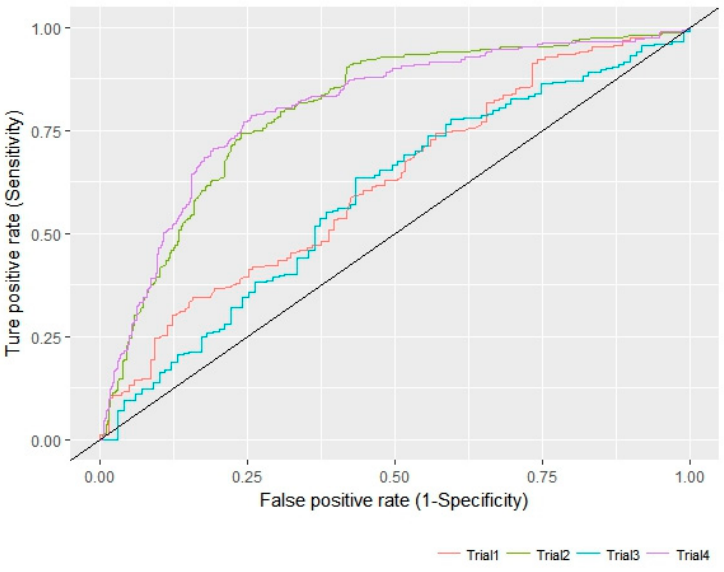
Figure 7. APRRR215 ROC curve and AUC.